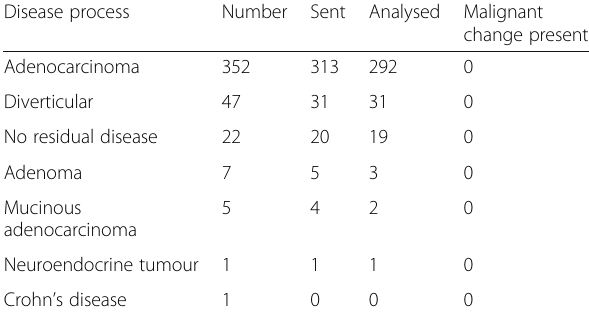
Table 2 Disease process involved and specimens analysed Disease